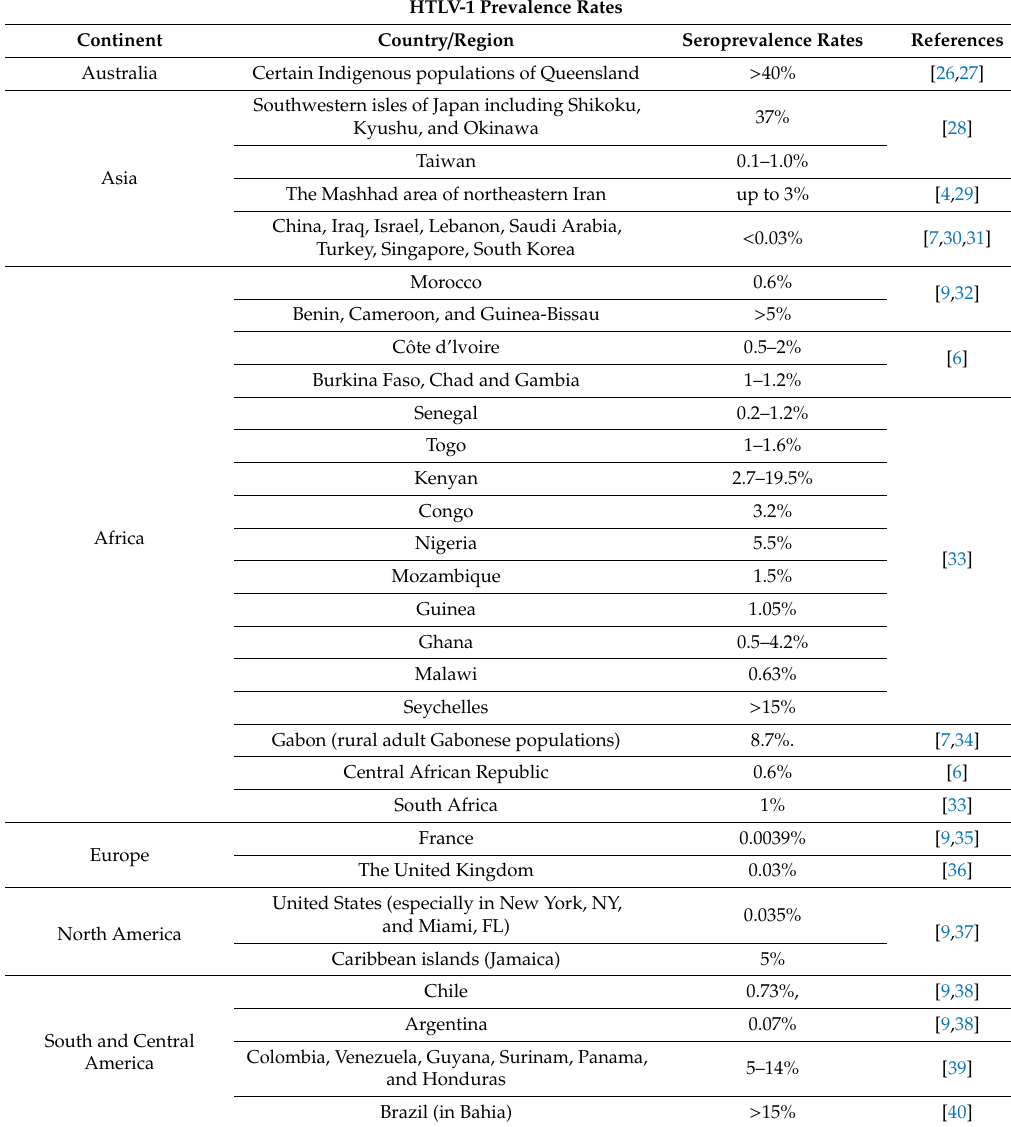
Table 1. The geographic distribution of HTLV-1 and its prevalence